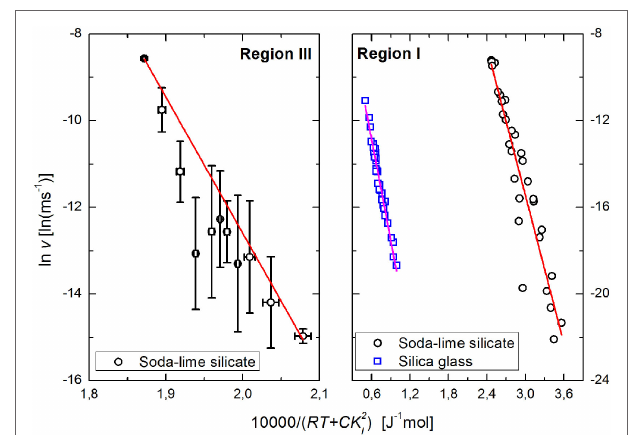
FIGURE 4 | Rate of subcritical crack growth as a function of total stored energy based on experimental data for soda–lime silicate glass on region I (right) (Wiederhorn and Bolz, 1970) and on region III (left) (Wiederhorn, 1967) and for silica glass on region I (Suratwala and Steele, 2003) (see text for details). Lines represent linear